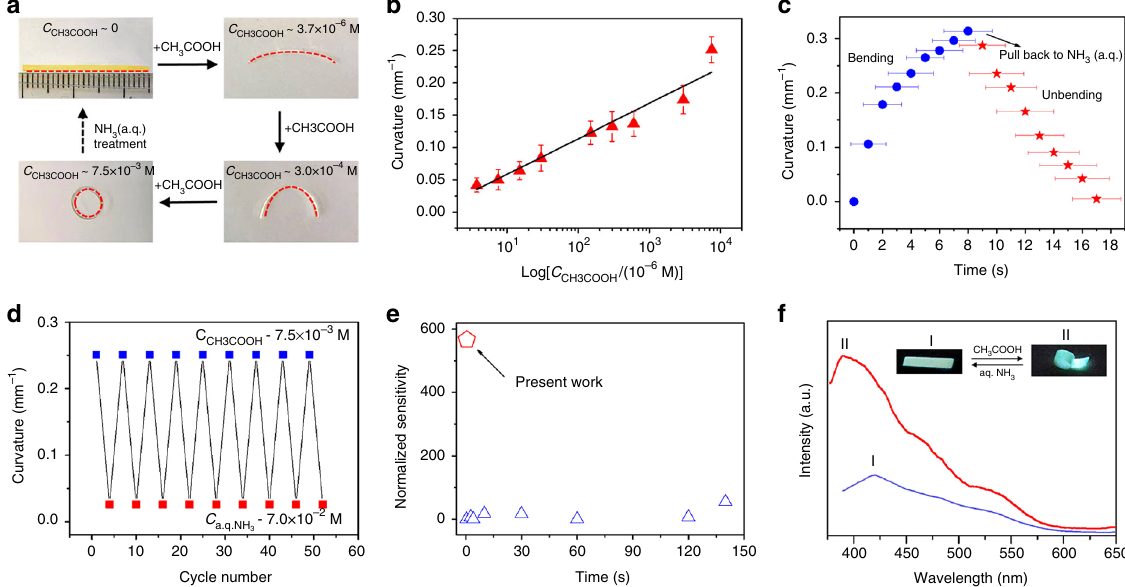
Fig. 3 The actuation of the Ptriaz-TA membrane actuator. a Shape deformation of a Ptriaz-TA membrane (1 mm × 25 mm × 50 µ m) in response to the addition of CH 3 COOH in water at 25 °C. Note: the membrane on the up-left was a top view and the rest was side view. The red dashed line indicates the membrane bottom. b The linear correlation of the membrane curvature against CH 3 COOH concentration (The method for statistical analysis is based on “ arithmetic mean, ” which is also used to other data analyses in this work). c Plot of curvature against time for the membrane actuator in CH solution (7.5 × 10 − 3 M) and back in aq. NH 3 (7 × 10 − 2 M). d The recyclability test upon alternatively treating the membrane with a.q. NH 3 and a.q. CH 3 COOH solution. e Plot of “ normalized sensitivity ” against time for the membrane actuator in current work (red pentagon) and from literature results (blue triangles) (Supplementary Table 1). f Fluorescence photographs (taken under λ = 365 nm) and spectra ( λ ex = 365 nm) record from the two states of membrane (1 mm × 25 mm × 50 µ m). I a.q. NH 3 treated Ptriaz-TA membrane; II after soaking in a.q. CH 3 COOH solution